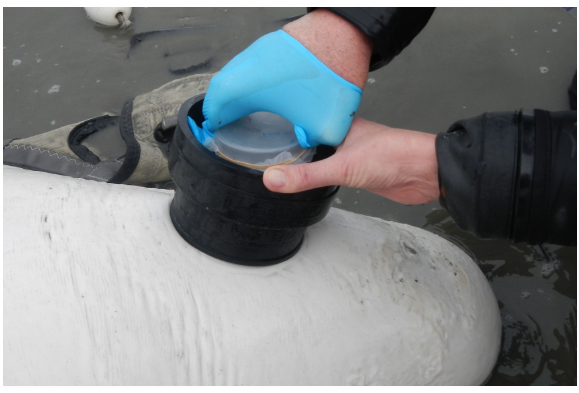
Figure 4. Collection of blow from a wild beluga in Bristol Bay, AK during live-capture and release health assessment studies. A plastic gasket was placed around the blowhole in order to minimize water contamination of blow samples. The blow plate was then held inverted in the center of the gasket for two repeated exhales.